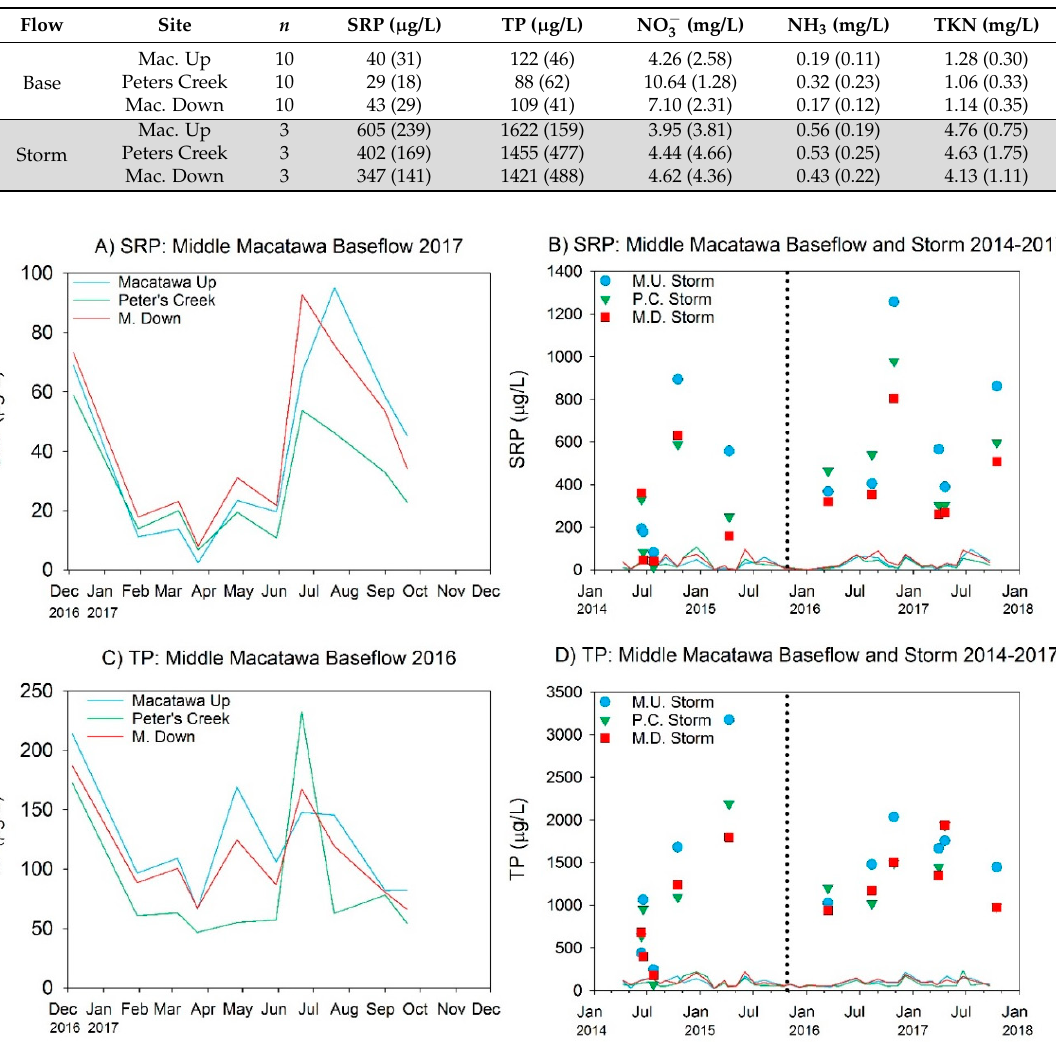
Figure 3. SRP and TP concentrations measured at Middle Macatawa restoration site in 2017 ( A , C ) and over total project history ( B , D ). Colored data lines in ( A,C ) magnify the 2017 baseflow data shown in ( B,D ). Symbols represent storm events. Vertical dotted lines represent approximate completion date of wetland restoration construction.